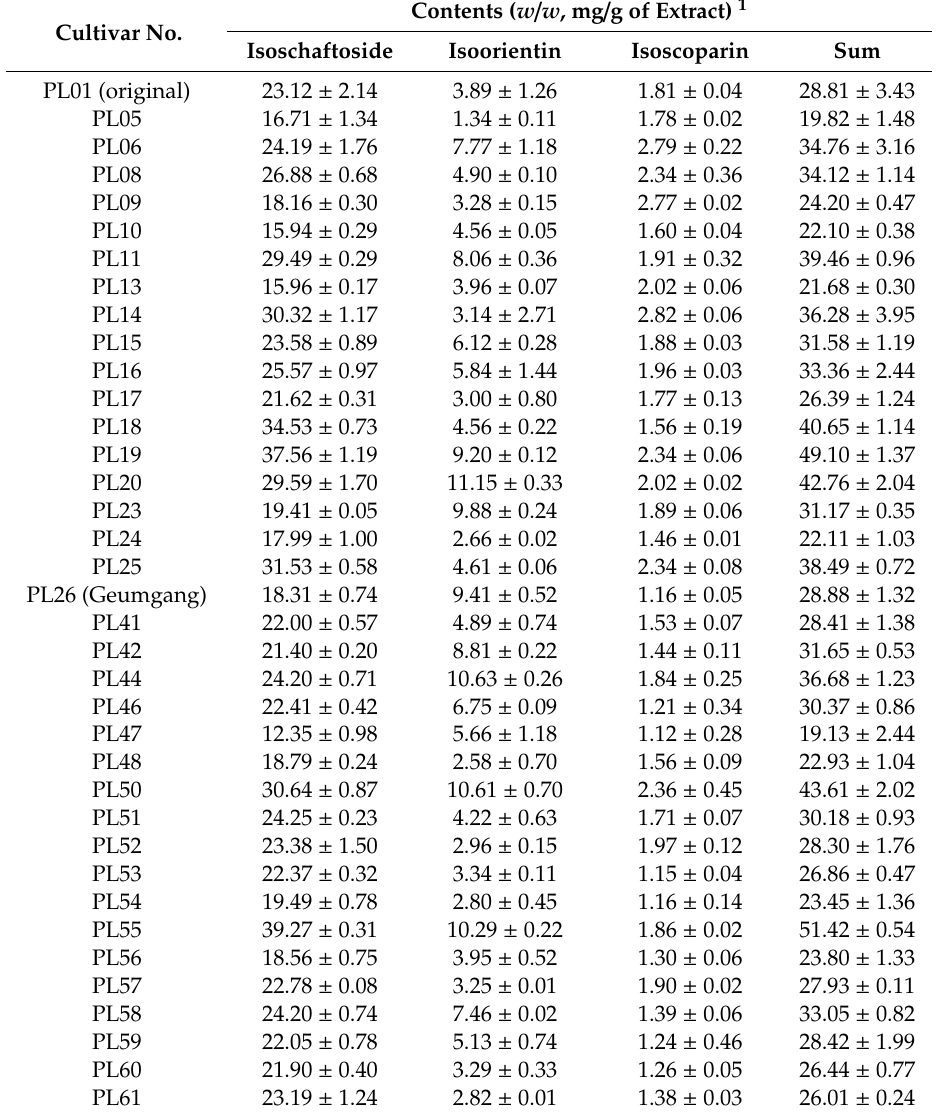
Table 4. Contents of three flavonoids in the wheat sprout